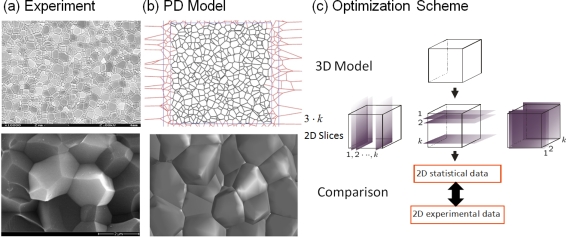
Optimization scheme as suggested in [168]. (a) 2D experimental photomicrograph (top) and an SEM picture of the 3D crystalline surface structure of Al2O3 (bottom). (b) 2D virtual slice of a power diagram (top) and the corresponding 3D surface structure obtained from this model. (c) Comparison between 2D experimental data of (a) and the 3D model of (b).